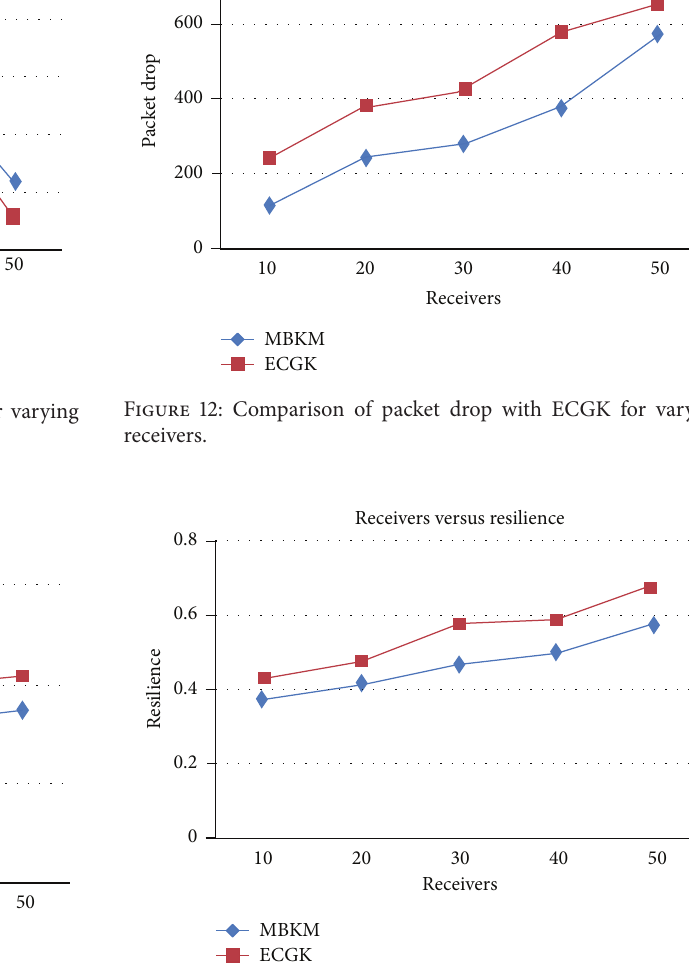
Figure 13: Comparison of resilience with ECGK for varying receivers.